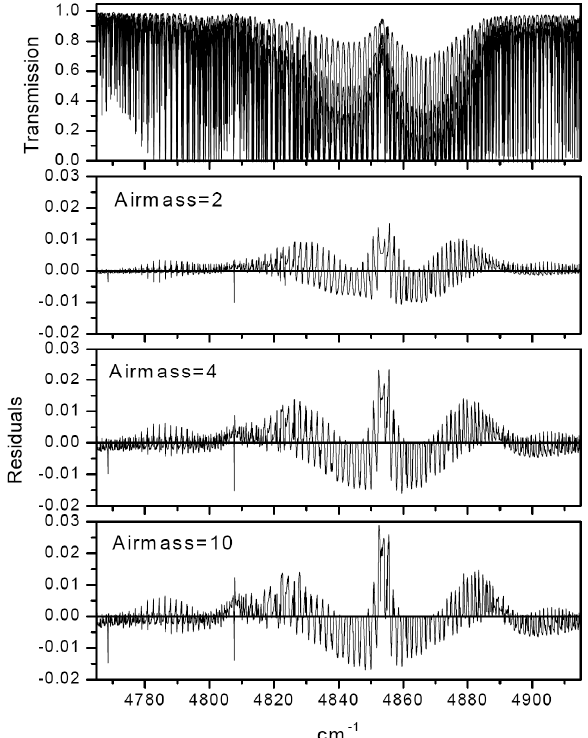
Figure 6. Transmissions (top) and fit residuals (bottom, due to neglecting LM) obtained in Fig. 6. Transmissions (top) and fit residuals (bottom, due to ne- Band#1 for MOPD=50 cm and airmasses of 2, 4, and 10. The narrow peaks in the residuals glecting LM) obtained in Band#1 for MOPD=50cm and airmasses near 4770 and 4807 cm -1 are due to Q branches which, being narrow, are significantly of 2, 4, and 10. The narrow peaks in the residuals near 4770 and affected by LM ( Rodrigues et al. , 1999). 4807cm − 1 are due to Q branches which, being narrow, are signifi- cantly affected by LM (Rodrigues et al.,